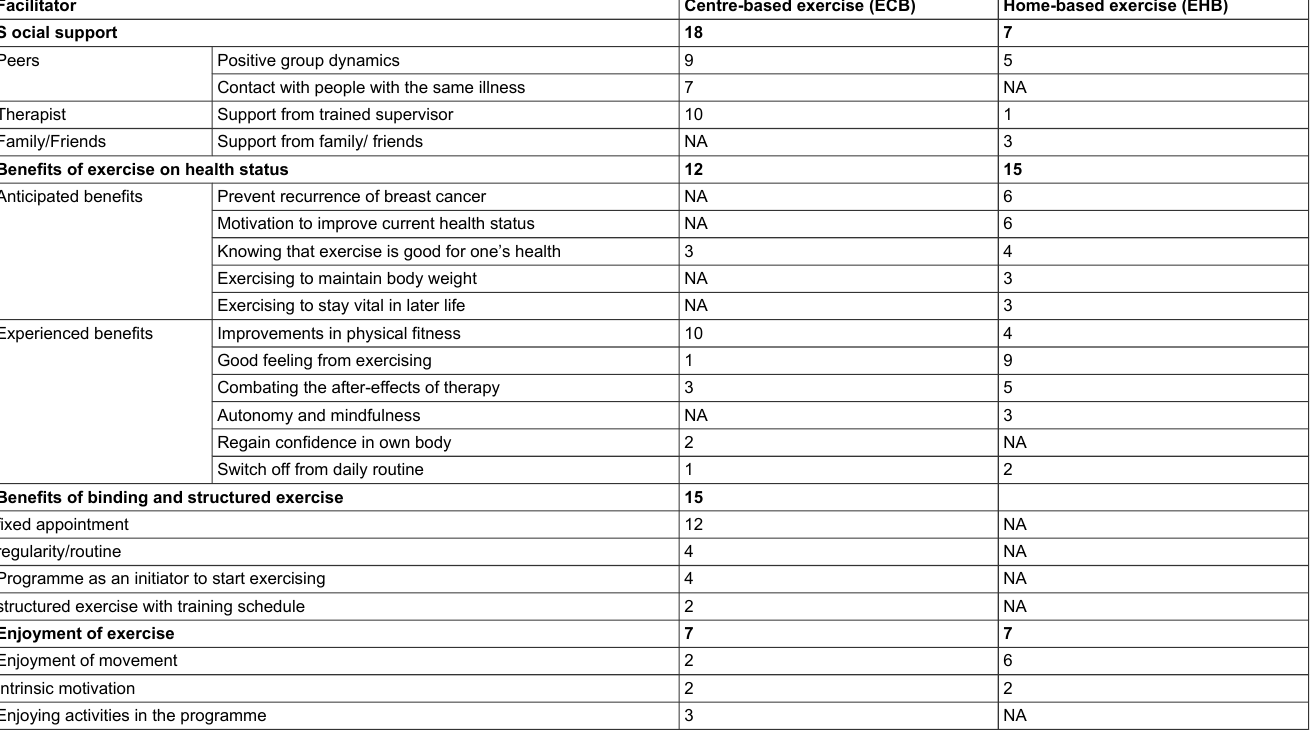
Table 2: Facilitators for exercise participation in home-based exercise and in centre-based exercise. Facilitator Centre-based exercise (ECB)